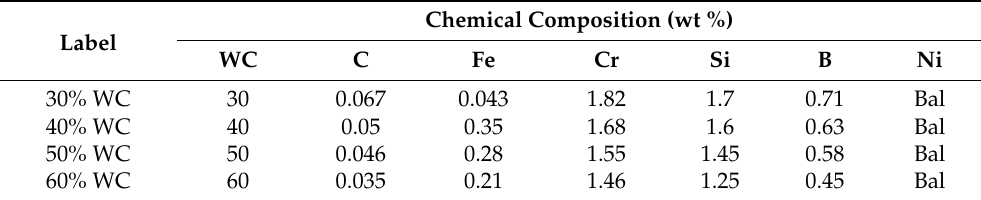
Table 1. Chemical composition of four powders.